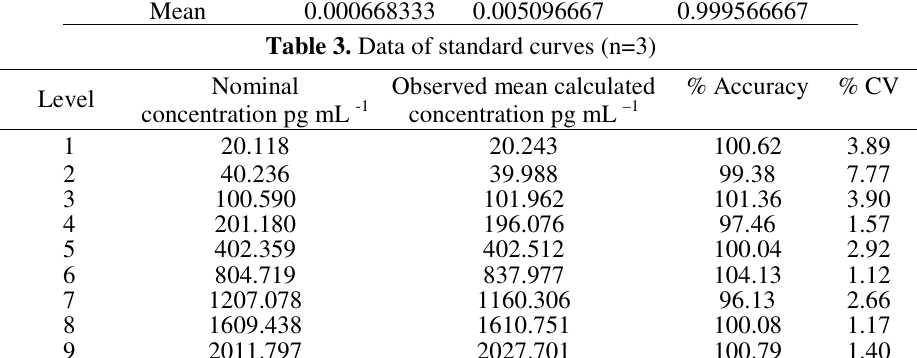
Table 3. Data of standard curves